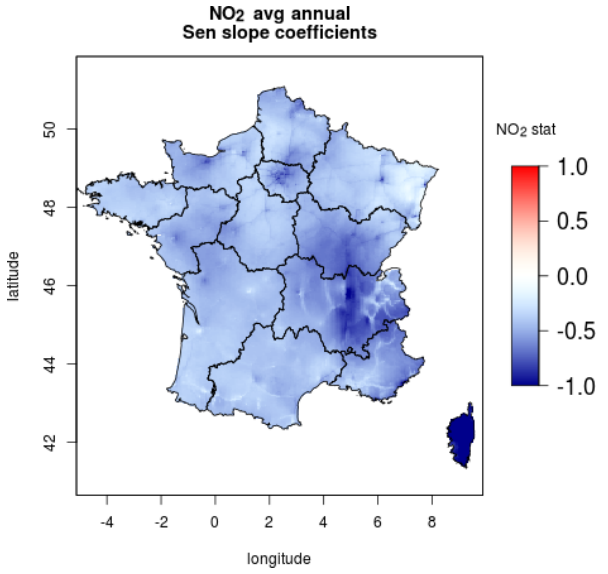
Figure 16. Trends in yearly mean NO 2 concentrations. Sen slope coefficients (µgm − 3 yr − 1 ) are calculated over the period 2000– 2015. Table 4. Validation scores for De Hoogh et al. (2018), Chen et al. (2019), and this study. The following scores are calculated by cross-validation for the three studies: Pearson correlation coefficient r 2 , the bias, and the root mean square error (RMSE). De Hoogh et al.